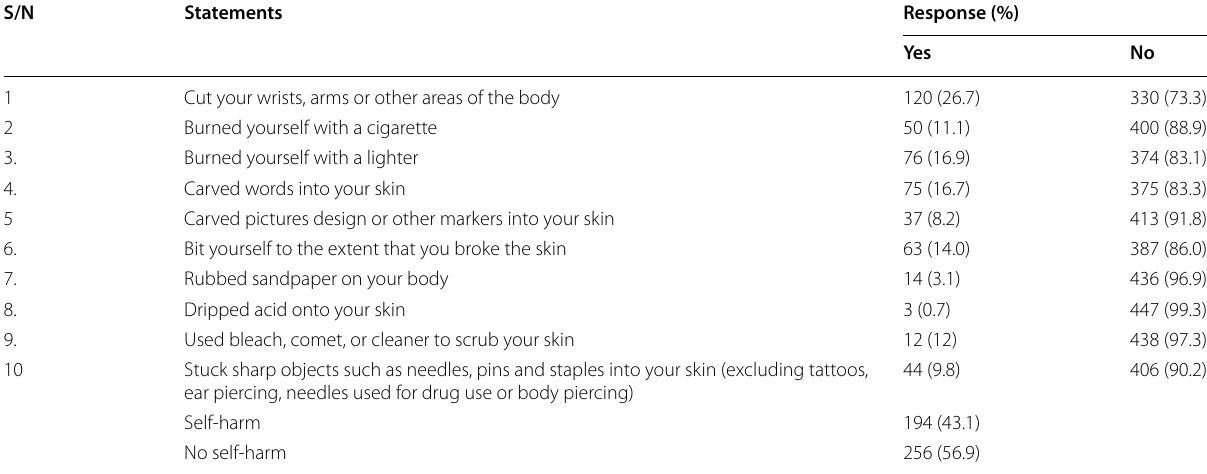
Table 7 Pattern of self-harm among the participants